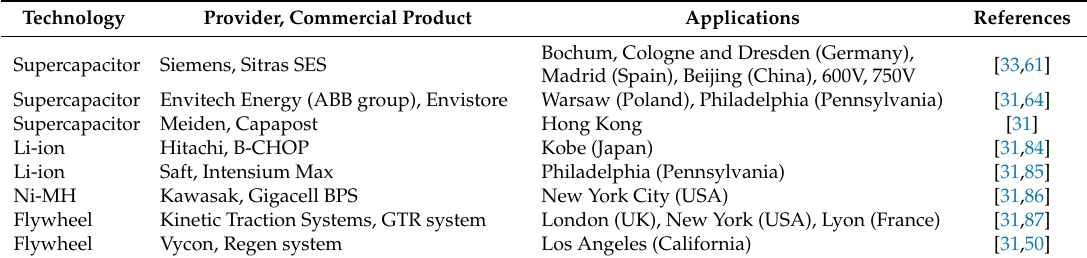
Table 2. Examples of wayside ESS